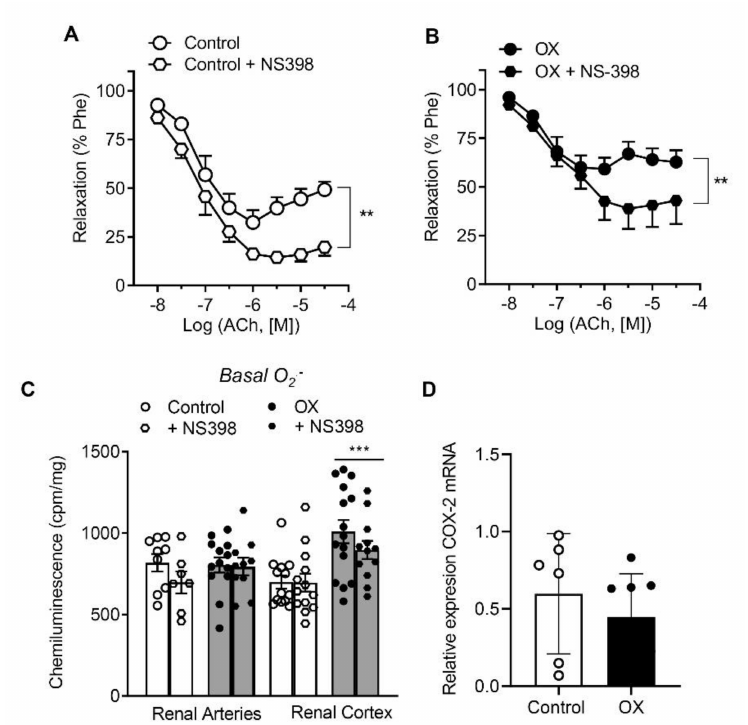
Figure 2. COX-2 inhibition improved renal endothelial relaxations in both control and OX rats and reduced elevated O 2 − levels in the renal cortex of the OX group, with no differences in COX-2 mRNA expression between the two groups. ( A , B ) Comparative effects of NS398 on endothelial relaxations of rat intrarenal arteries in the Control ( A ) and OX groups ( B ). Results are given as a percent of the phenylephrine (Phe) contraction as the mean ± SEM of 7–8 arteries (4 animals). Statistical differences were calculated by paired t -test ** p < 0.01. ( C ) Effect of NS398 on basal ROS generation in the renal arteries and kidney cortex of control and hyperoxaluric rats, measured by lucenin-enhanced chemiluminescence. Results are expressed as counts per minute (cpm) per mg of tissue. Bars represented mean ± SEM of 5–10 animals. Statistical differences were calculated with t -test *** p < 0.001 versus basal levels. ( D ) Comparative COX-2 mRNA expression in the renal arteries of the control group ( n = 6) and OX group ( n = 8), performed by RT-PCR. The delta–delta CT method was used to determine the fold change gene relative expression in the arteries that were treated with water (control group) and with 0.75% EG (OX group). The values represent the mean ± SD. No statistical differences were